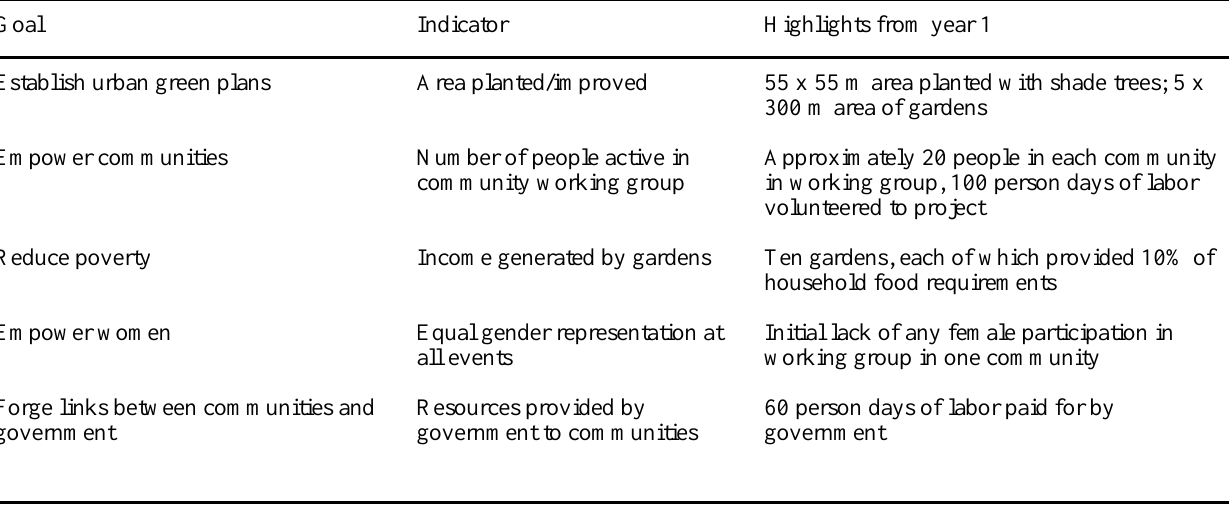
Table 3. Goals, indicators, and results from Bangkok urban greening project (adapted from Fraser